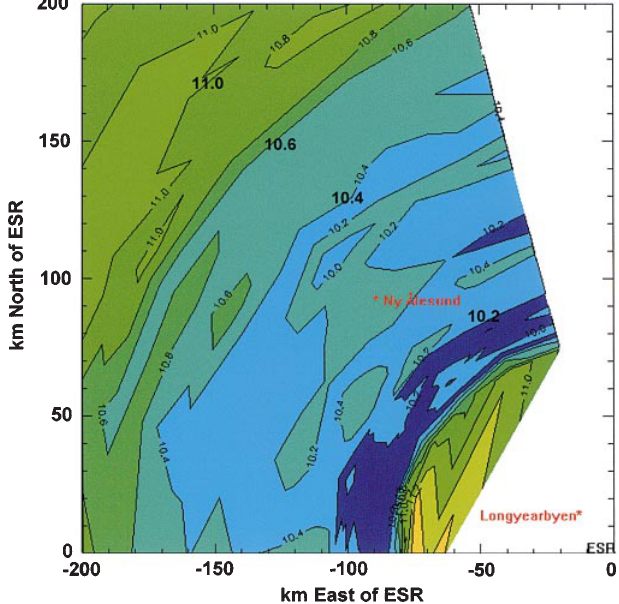
Fig. 5. Z -component magnetometer records for Ny A ˚ lesund for 19 ( top ) and 20 ( bottom ) November, 1997. On each day, the record starts at 12 UT and extends for a